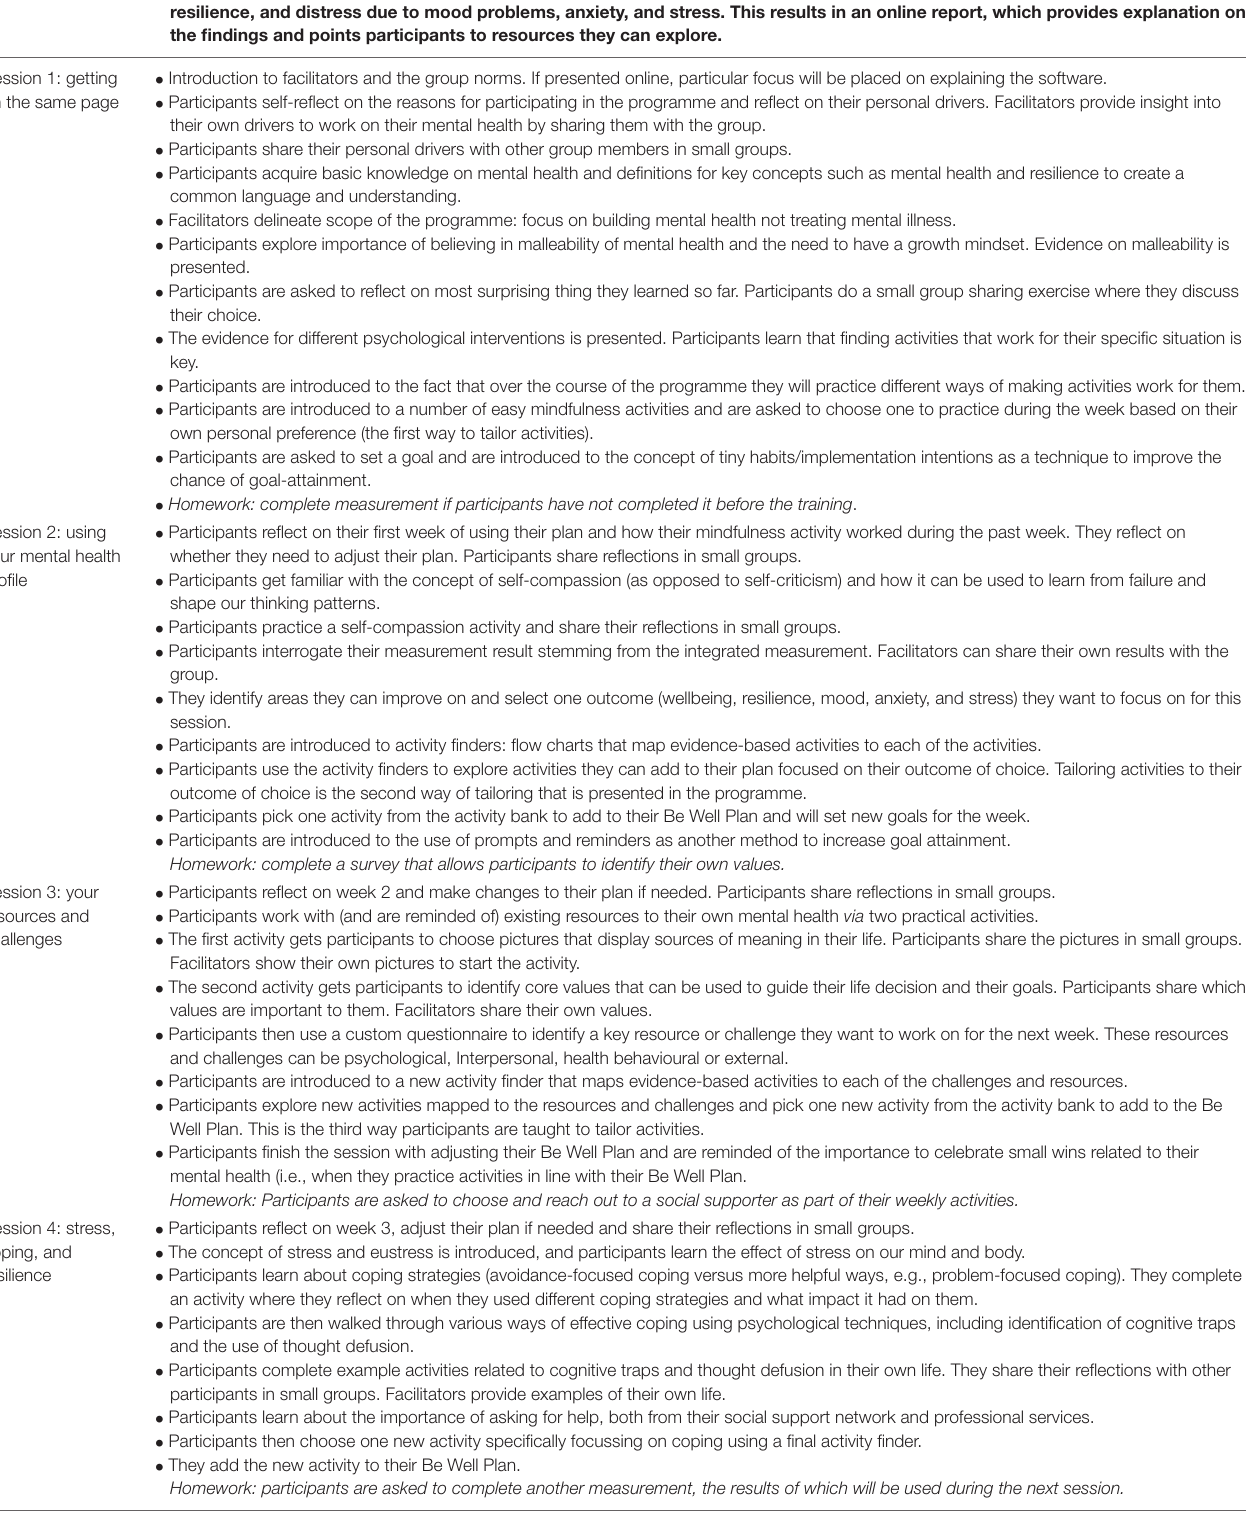
TABLE 3 | Table describing the overall content for the individual sessions of the Be Well Plan.